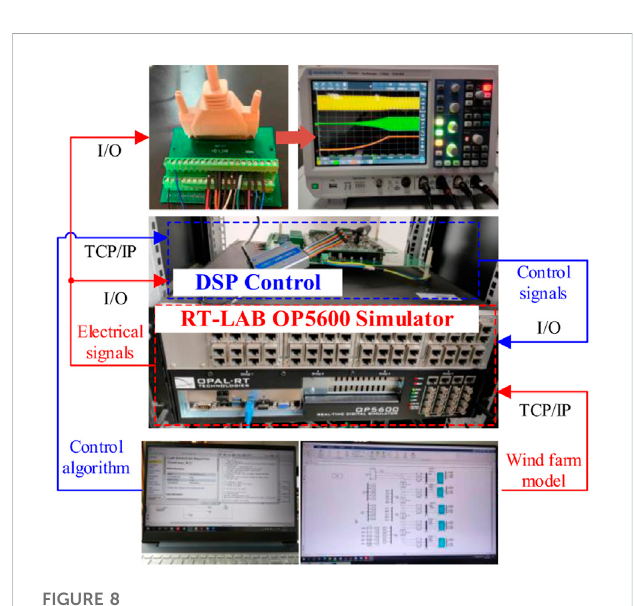
FIGURE 8 RT-LAB hardware in the loop experimental platform of